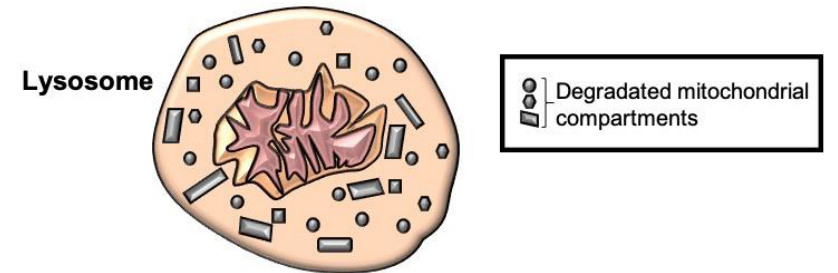
Figure 3. Ubiquitin-mediated mitophagy—the PINK1–PARKIN-mediated pathway. One of the prominent members of ubiquitin-mediated mitophagy is the PINK1–PARKIN pathway. The loss of the MMP is considered to be the primary initiator of mitophagy. The decline of MMP promotes the accumulation of PINK1 on the OMM by destabilizing the IMM protease, PARL. PINK1 fulfills the function of posttranslationally labeling OMM proteins with ubiquitin and recruits and activates the cytosolic E3 ubiquitin ligase PARKIN. The function of PARKIN is to ubiquitinate OMM proteins, such as Mfn1 / 2, VDAC, and TOM proteins, triggering the formation of ubiquitin chains. The